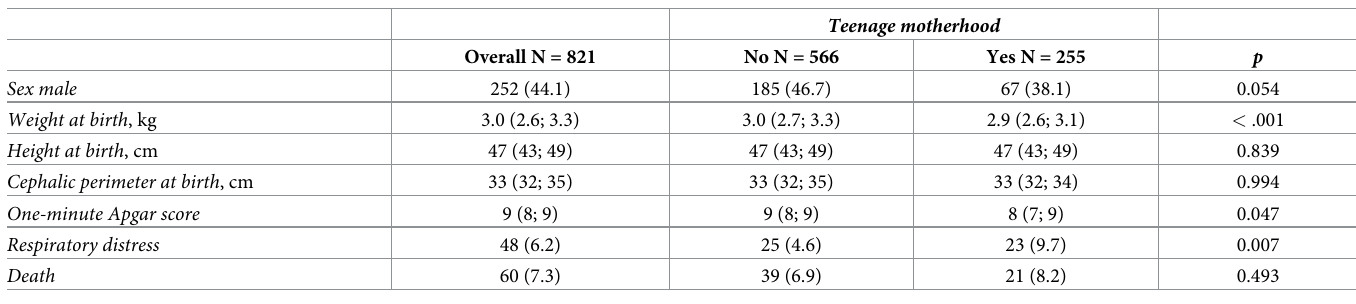
Table 3. Characteristics of the